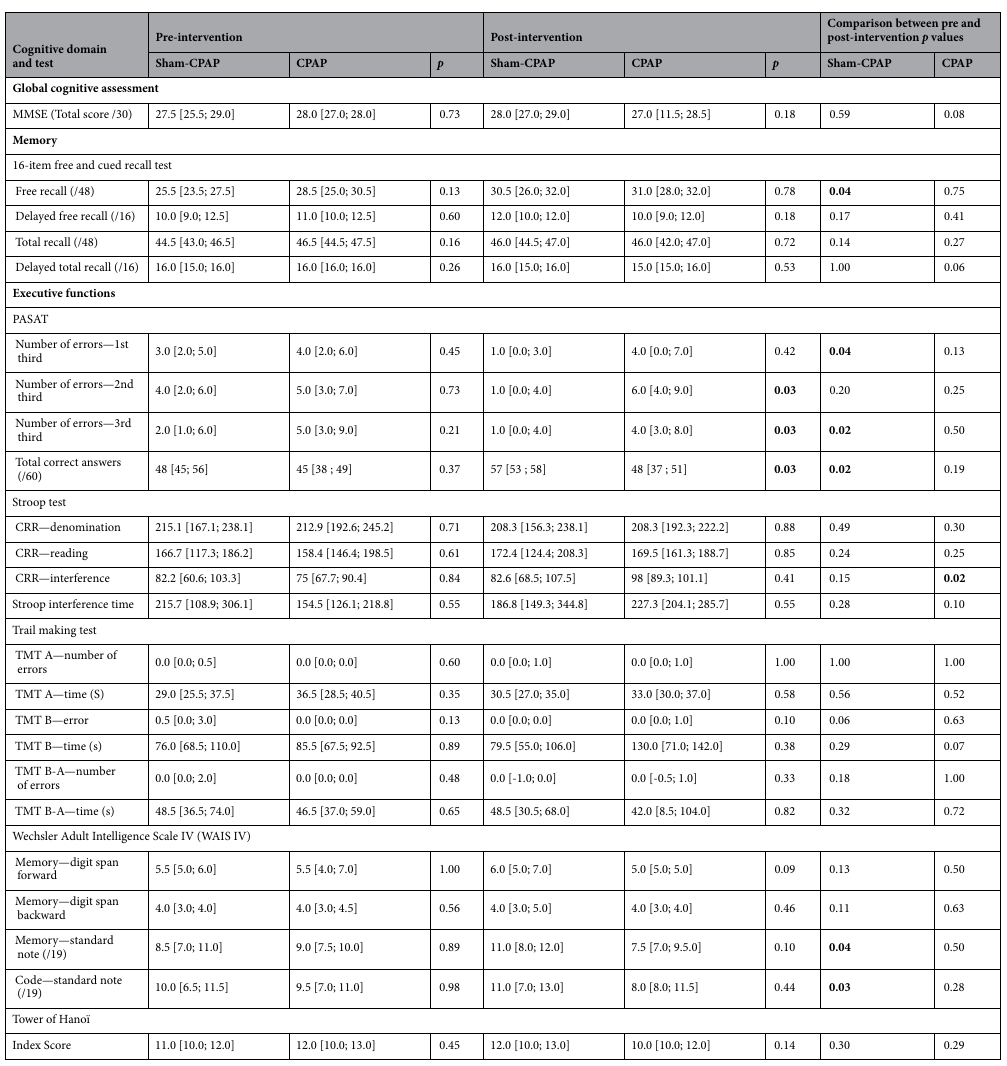
Table 2. Results of the neuropsychological assessments and impact of CPAP treatment. CPAP continuous positive airway pressure, CRR correct response rate, MMSE mini mental state examination, PASAT paced auditory serial addition test, TMT trail making test; WAIS Wechsler Adult Intelligence Scale. Analysis: Data are presented as median [Q1; Q3]. Analysis of data by Wilcoxon–Mann–Whitney test for continuous data and by a χ 2 or Fisher exact test for categorical data. Significant results are displayed in bold. MMSE: the displayed result is the total score of the test, with a maximum score of 30, higher score indicating better global cognitive functioning. 16-item free and total recall: for the free and total recall tests, results are presented as the sum of the three consecutive trials, with a maximum score of 48. For the delayed free and total recall tests, maximum score is 16, higher score indicating better performance. Paced Auditory Serial Addition test: A pre-recorded tape delivered a random series of 61 numbers from 1 to 9, at a constant rate of 1 number every 4 s. Participants were instructed to add pairs of numbers such that each number was added to the one that immediately preceded it on the recording: the second was added to the first, the third to the second, the fourth to the third, and so on. The response had to be given before the presentation of the next stimulus (4 s later). The sum of any given pair never exceeded 15. The number of correct responses was recorded (PASAT maximum = 60). Stroop test: The test is composed of 3 different parts: (1) Denomination: participants have to name 48 colored patches (2) Reading: participants have to read 48 color names, written in a congruent color (The word “Red” written in red color font) and (3) Interference: task requiring response inhibition. Participants have to give the color font of 48 color names, written in an incongruent color (The word “Blue” written in green color font; correct answer: green). For each part of the test, time and number of errors are recorded and account for task performance. The displayed results are the correct response rates (CRR = Response rate per second × Percentage of correct responses) for the three parts of the test. Higher CRRs indicate better performance. Stroop interference time = Time for Stroop Interference test (s) − (Time for Stroop Denomination test (s) + Time for Stroop reading test (s))/2. A low score (seconds) indicates better executive function. Trail Making Test: the displayed results are the time and number of errors for each part of the test, as well as the difference between the time and number of errors between test B and